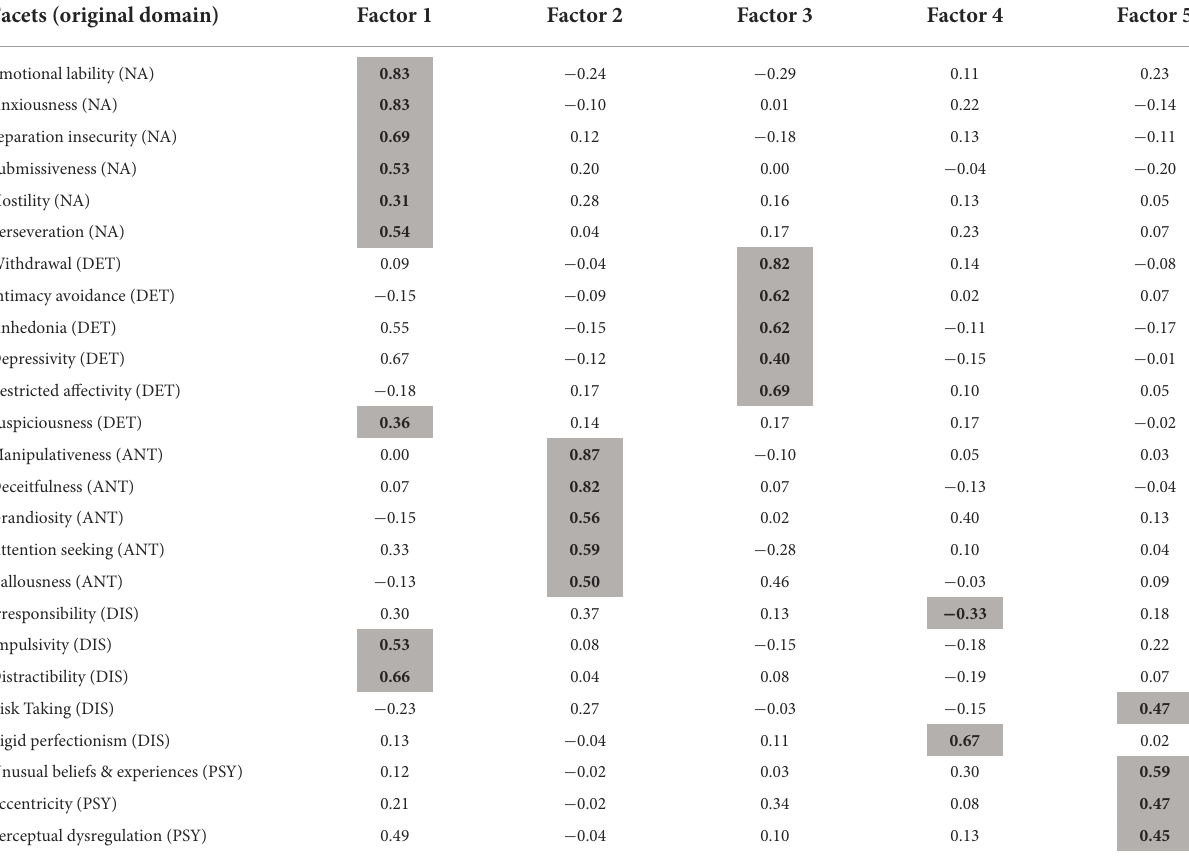
TABLE 5 Factor loadings of PID-5 (paper-and-pencil) domains according to Exploratory Factor Analysis for the 5-factor model ( N = 730). Facets (original